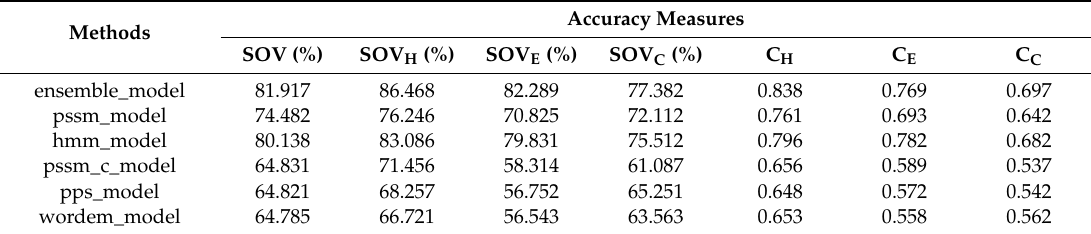
Table 1. Segment Overlap Measure (SOV) scores and (matthews correlation coe ffi cients) MCC results by six di ff erent methods for the validation